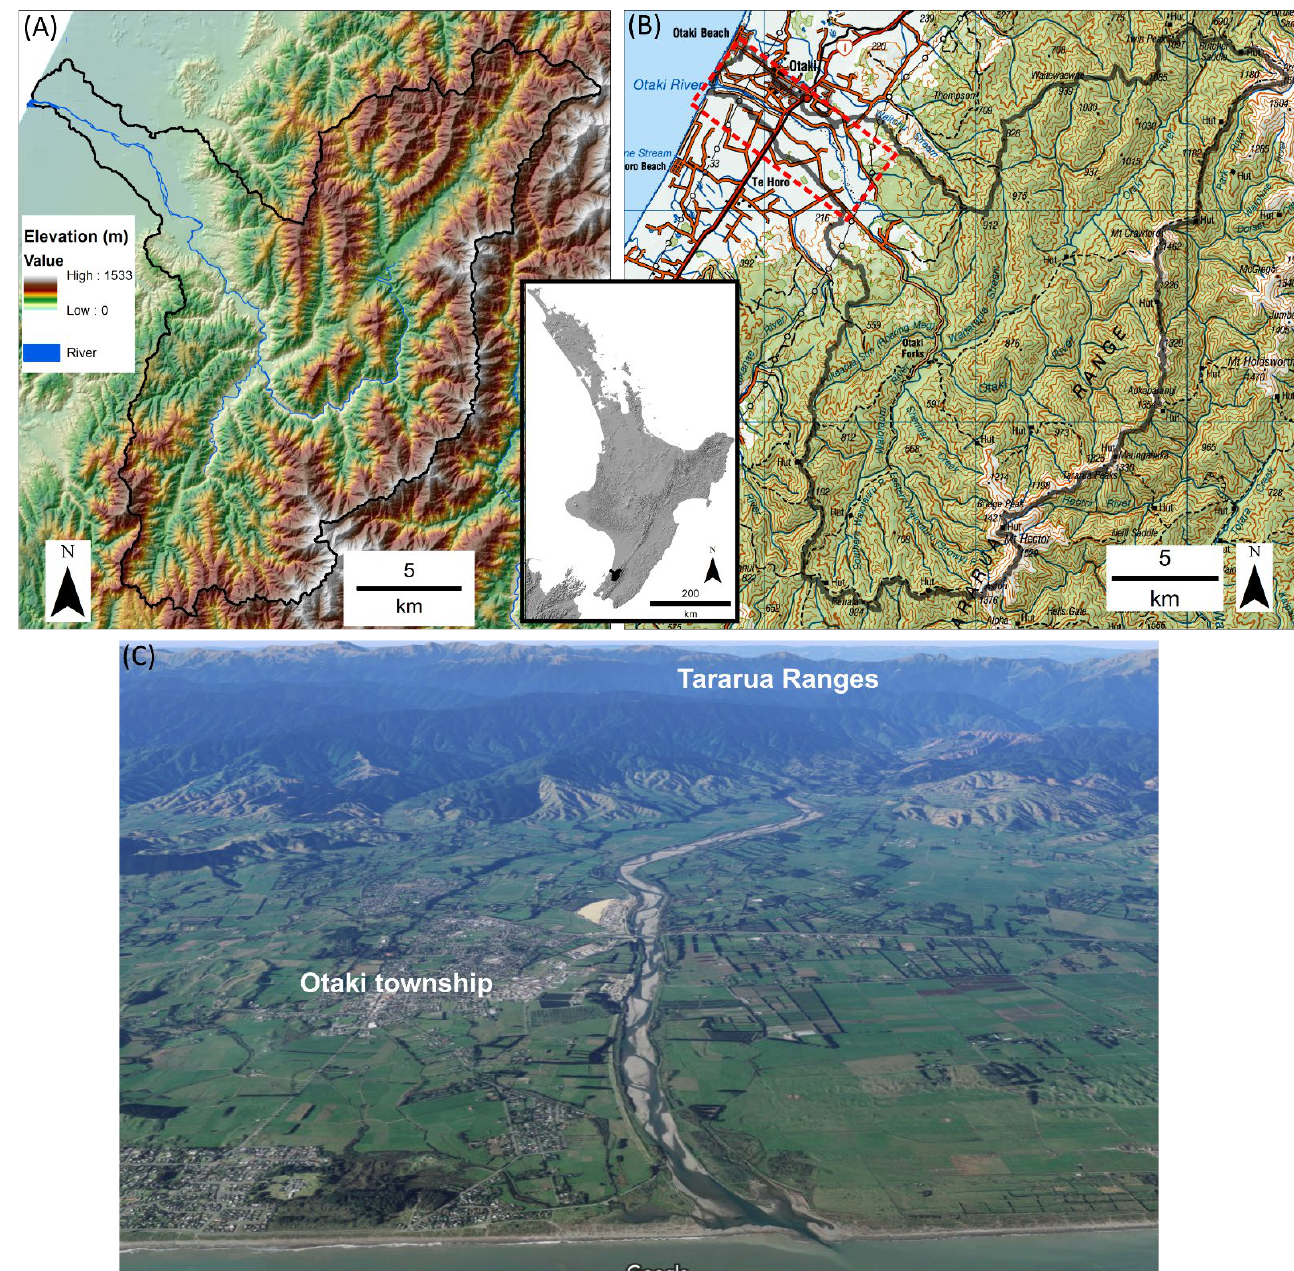
Figure 5. ( A ) Ōtaki catchment terrain and location on the North Island of New Zealand (inset); ( B ) topographic map showing the intensively developed coastal strip, while forest cover remains across much of the catchment—the red dashed box indicates the lower river area of interest in this study; ( C ) oblique aerial image looking upstream across the narrow coastal plain to the Tararua Ranges.